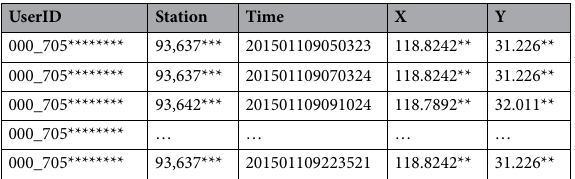
Table 5. User’s mobile phone signaling data. Source Author made.